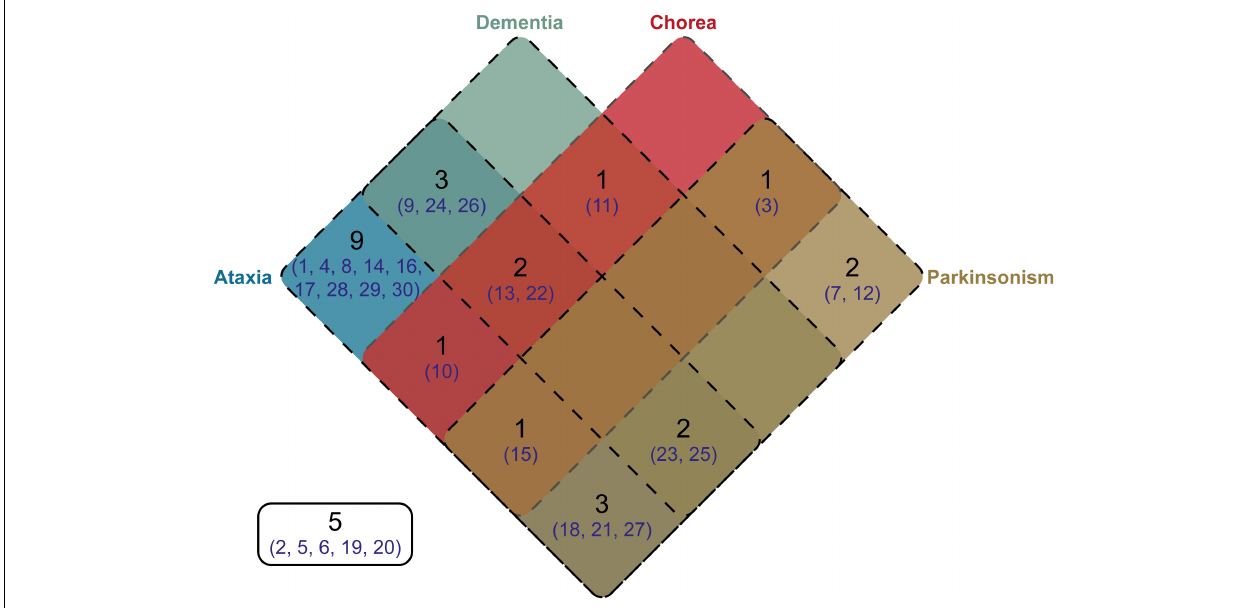
FIGURE 4 | Venn diagram showing the distribution of phenotypes within the cloned SCA17 cohort. Phenotype information was available for 25 patients out of the 30 individuals in the cohort. The number of patients falling into a specific symptom category is shown in black, whilst the subject numbers corresponding to the clone frequency tables ( Supplementary Tables S1 , S2 ) are shown in dark blue. Patients with particular phenotypes are enclosed by the appropriate rounded rectangle (Ataxia, blue; Dementia, green; Chorea, red; and Parkinsonism, brown). Five subjects either were asymptomatic or no phenotype information was